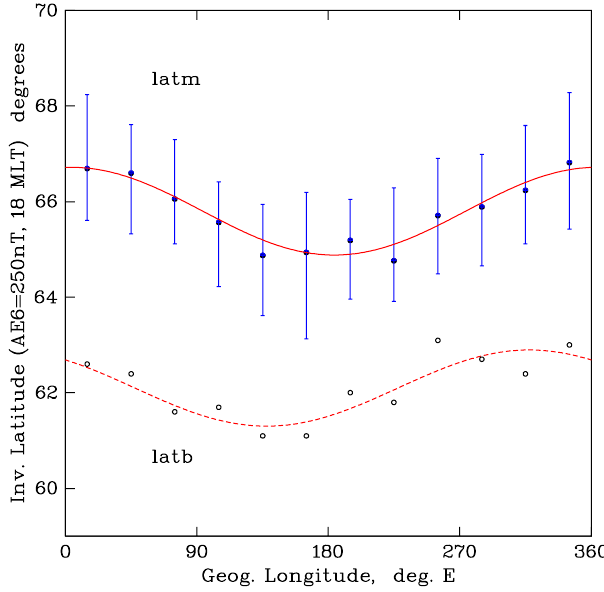
Fig. 5. Position of the equatorward trough wall as a function of geographic longitude. The format of data presentation corresponds to that of Fig. 3, except that this time the latitude range has been considerably reduced, and sin- and cos- functions have been fitted to the median values. The analytical forms of these regression curves are contained in Eqs. (2) and (3). Note that the results presented in this figure refer to a geomagnetic activity level of AE 6=250nT and a magnetic local time of